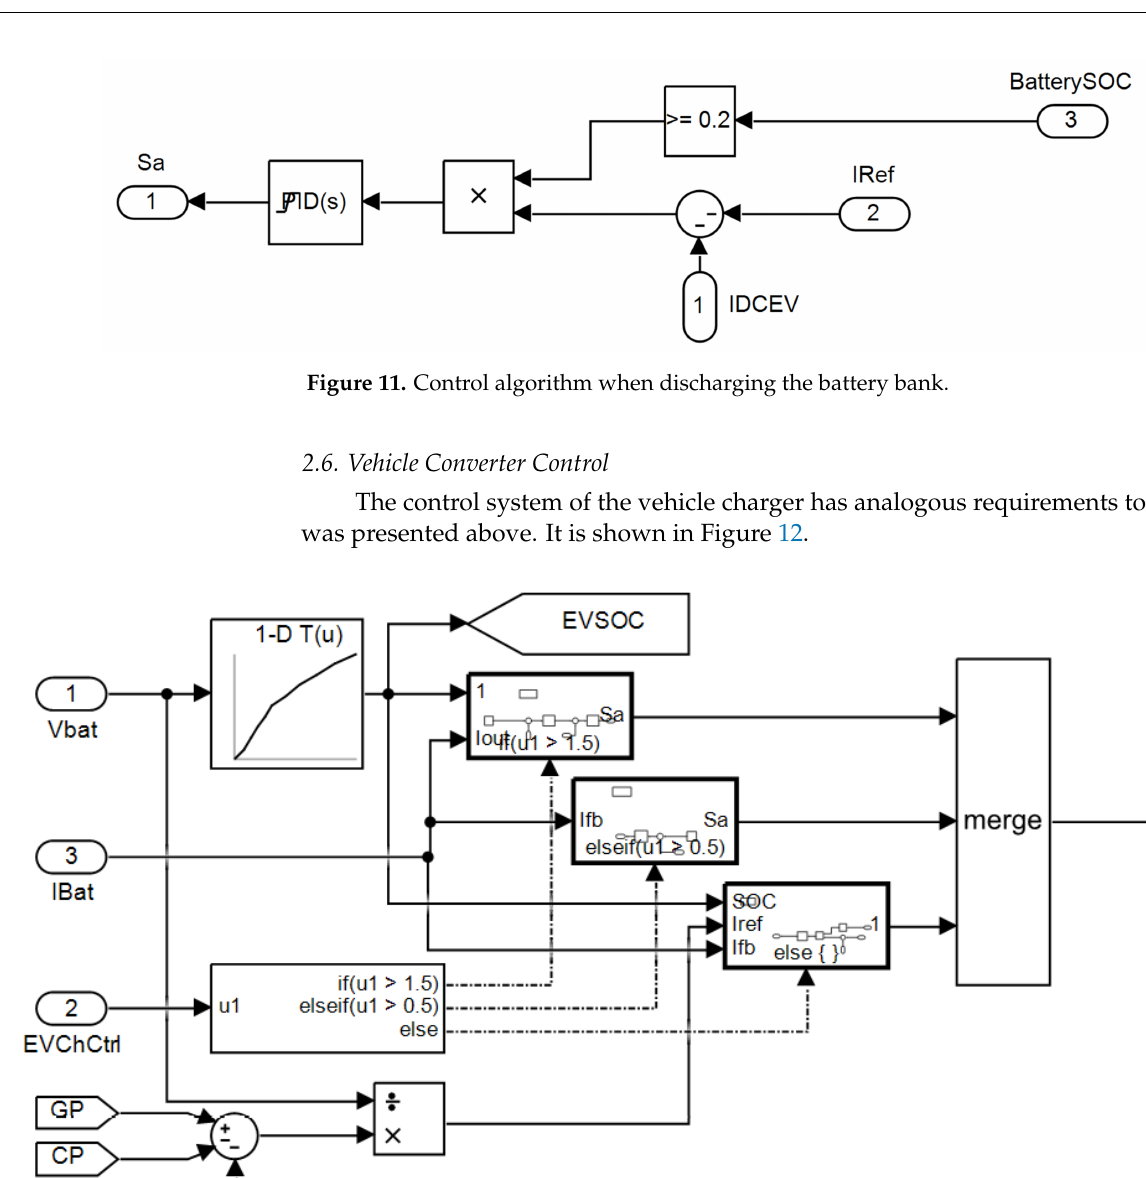
Figure 13. A flowchart discussing the algorithm of the converter connected to the EV. 2.7. AC/DC Converter The control system for the converter is the standard decoupled control presented in Figure 14 [6]. The main idea behind this control algorithm is to remove the disturbance from ω LI d and ω LI q parts and obtain a simplified dependence of current charging the output capacitor only from the DQ transformed currents (that are the control goal). The refences for the Id and Iq currents can be set accordingly to control the Active and Reactive power consumed from the ac bus. As for the current application (small households) the reactive power is not measured, so the Iq and I0 current references are set to zero.